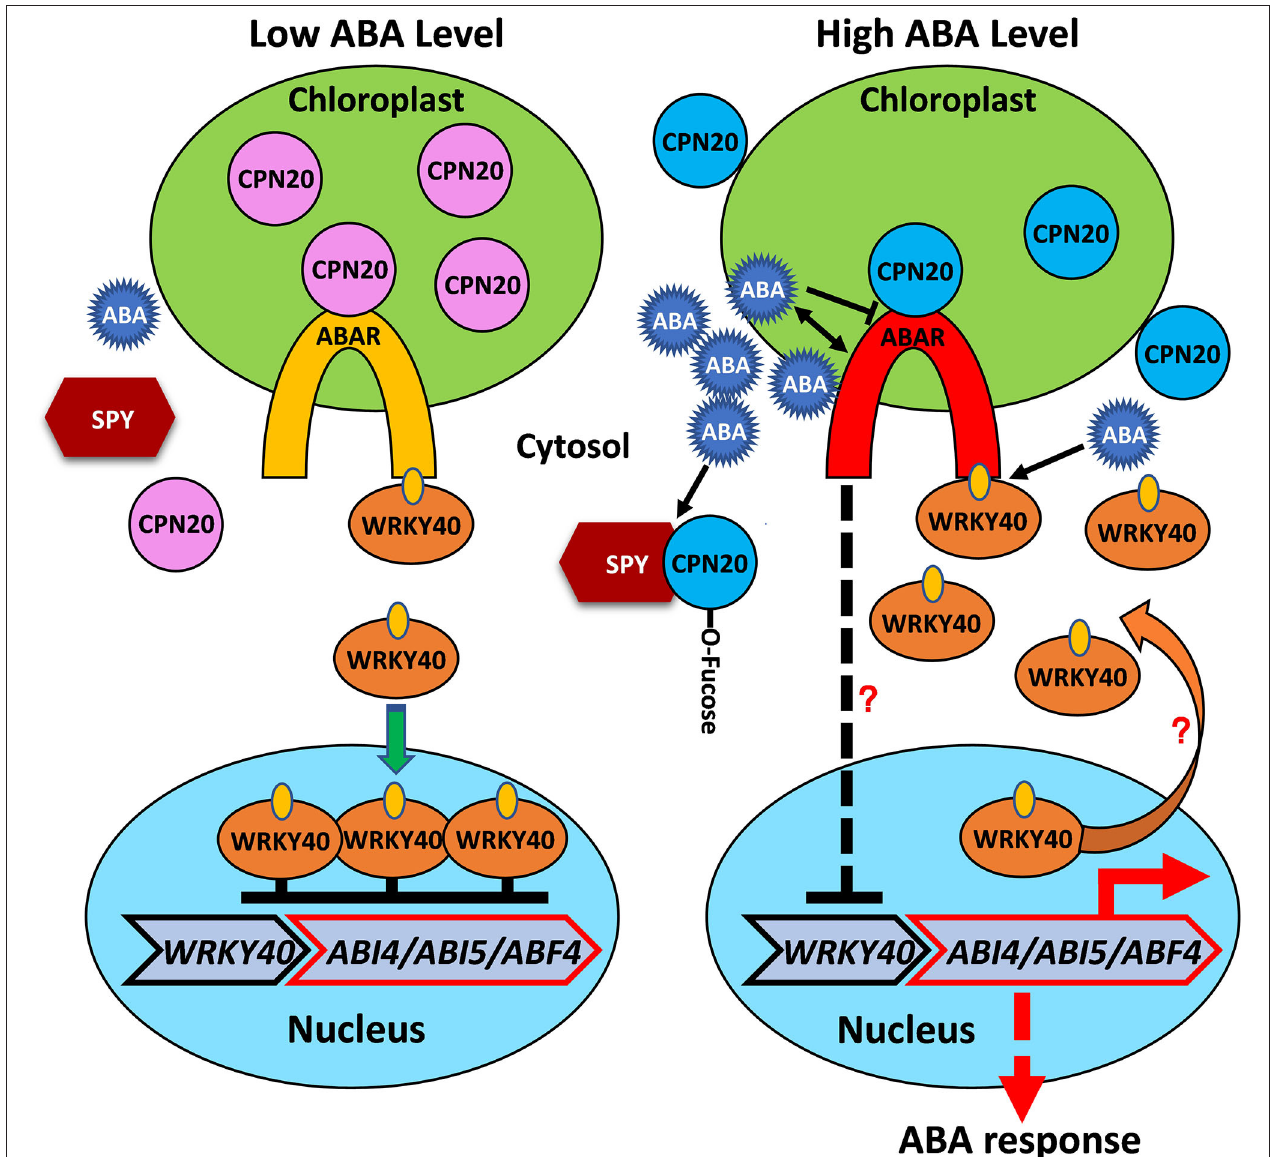
FIGURE 7 | Proposed working model for O -fucosylatation of CPN20 and its functional consequences. The chloroplast envelop-localized ABA receptor ABAR interacts with the WRKY40 transcription factor, a central negative regulator, which inhibits expression of ABA-responsive genes, such as ABI5, ABI4, and ABF4 . A high level of ABA signal promotes ABAR-WRKY40 interaction and translocation of WRKY40 from the nucleus to the cytosol, represses WRKY40 expression with unknown mechanisms. These processes lead to relief of the inhibition of ABI5 expression by nucleus-localized WRKY40. In the presence of a high level of ABA, enhanced SPY-CPN20 interaction facilitates O -fucosylation of CPN20 and reduces its localization in the chloroplast. This de-represses CPN20 inhibition of ABAR-initiated ABA signaling along with ABA-inhibited ABAR-CPN20 interaction. Note that dash line indicates possibly with an indirect process, question mark represents with unknown